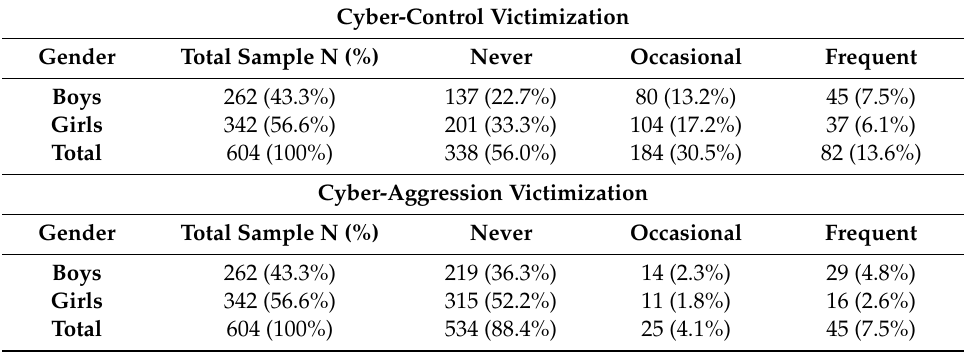
Table 1. Distribution of adolescent boys and girls according to their cyber dating violence victimization experience.